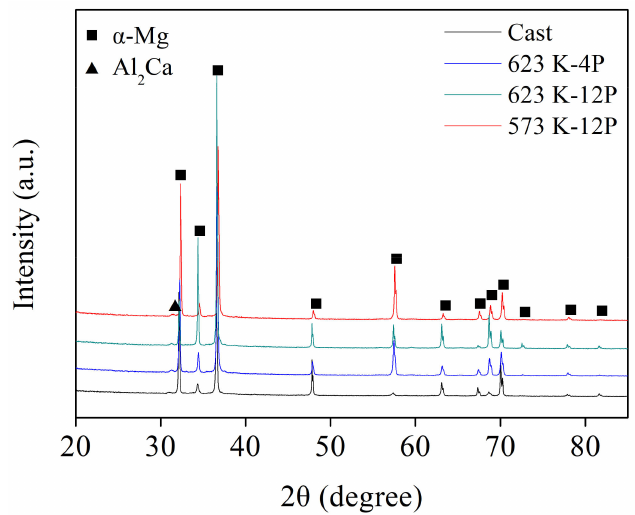
Figure 1. X-ray di ff ractometer (XRD) patterns of as-cast and ECAP-ed